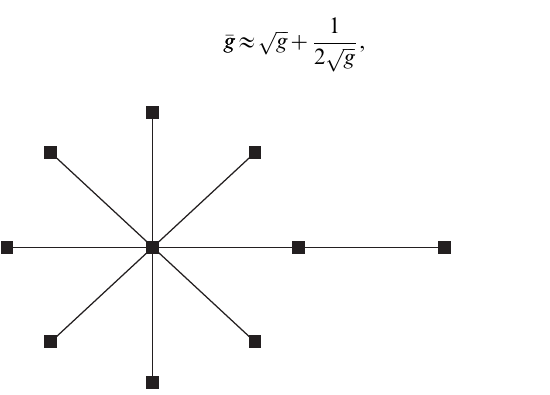
Figure 3. Neutral network-like fitness landscapes. There is a sequence with g ~ 8 neutral neighbors and a tail of neutrals with the length l ~ 2 .